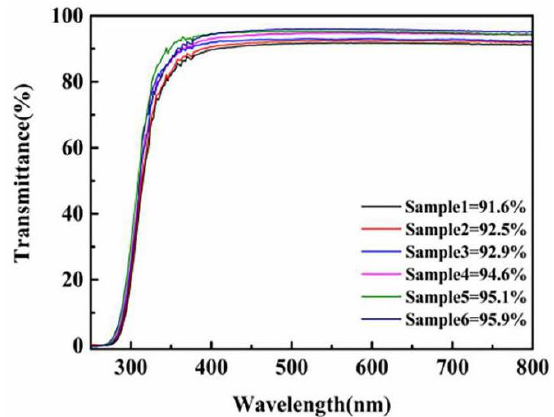
Figure 11. Transmittance of different Si Ti ratio coatings (Note: the solid content of samples 1 – 6 is 30%, 25%, 20%, 15%, 10% and 5%, respectively).